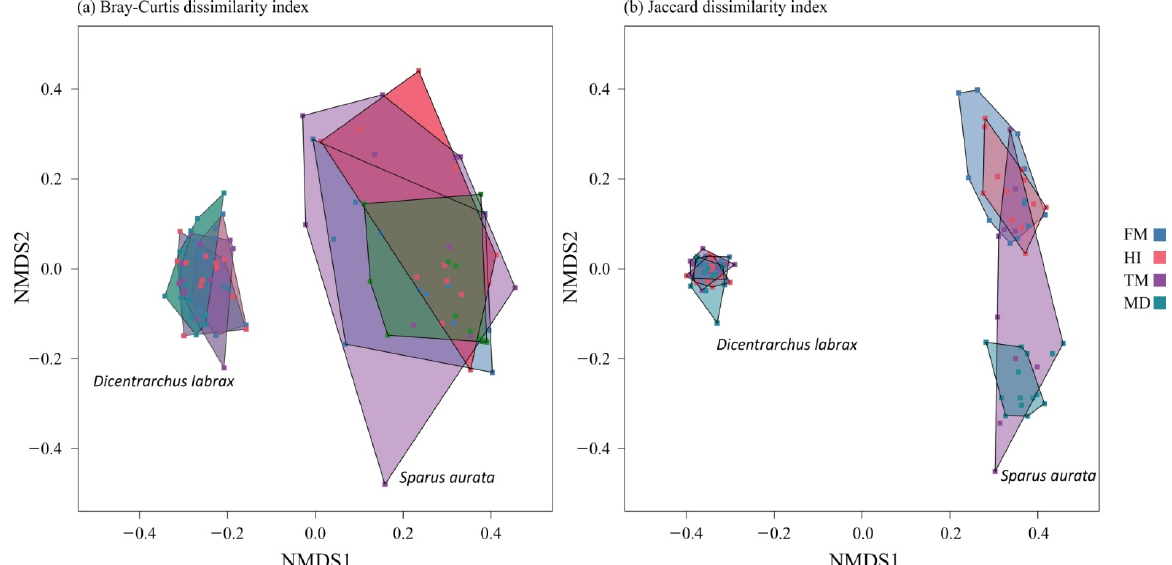
Figure 3. Nonmetric multidimensional scaling (NMDS) plots of the gut bacterial communities of Dicentrarchus labrax and Sparus aurata fed control (FM) and insect meal-containing diets (HI, TM, MD), derived from ( a ) Bray–Curtis dissimilarity index and ( b ) Jaccard dissimilarity index. Different colors indicate different diets. Abbreviations according to Figure 1.